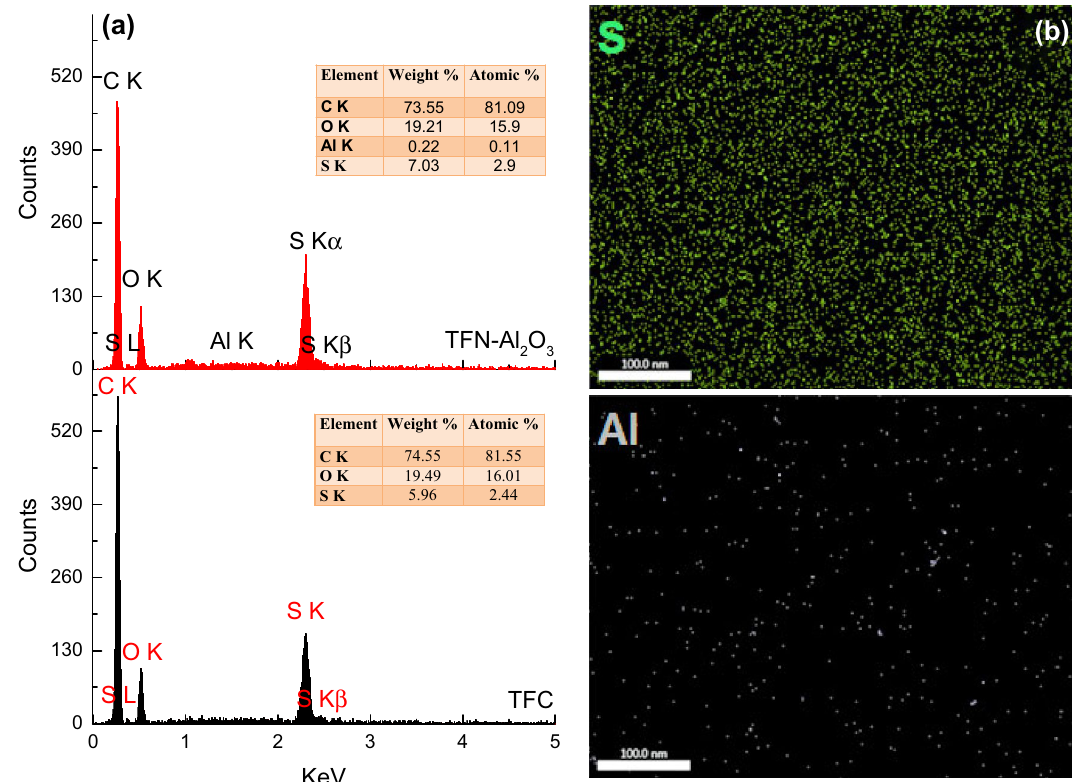
Figure 12. EDX analysis of TFC and 0.03 TFN-Al 2 O 3 membranes ( a ) and EDX mapping of 0.03 TFN-Al 2 O 3 membranes showing the distribution of sulfur and